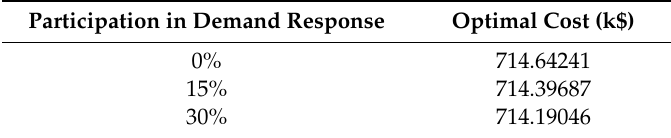
typical day in week